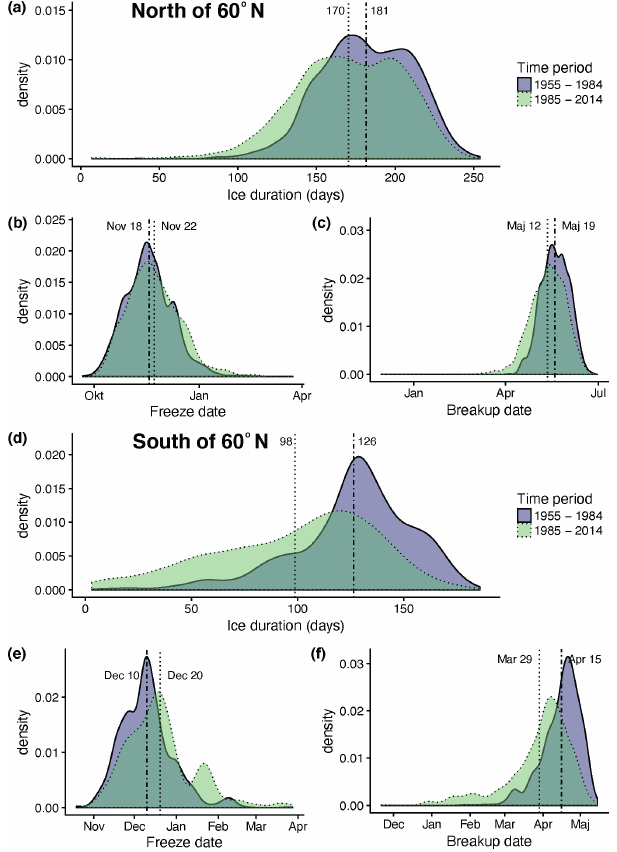
Figure 4. Probability density functions for ice duration (a, d) and freeze (b, e) and break-up dates (c, f) from northern (a–c) and south- ern (d–f) Sweden during 1955–1984 and 1985–2014. Vertical lines represent mean values, where dot-dashed and dotted lines represent the former and latter 30-year periods,